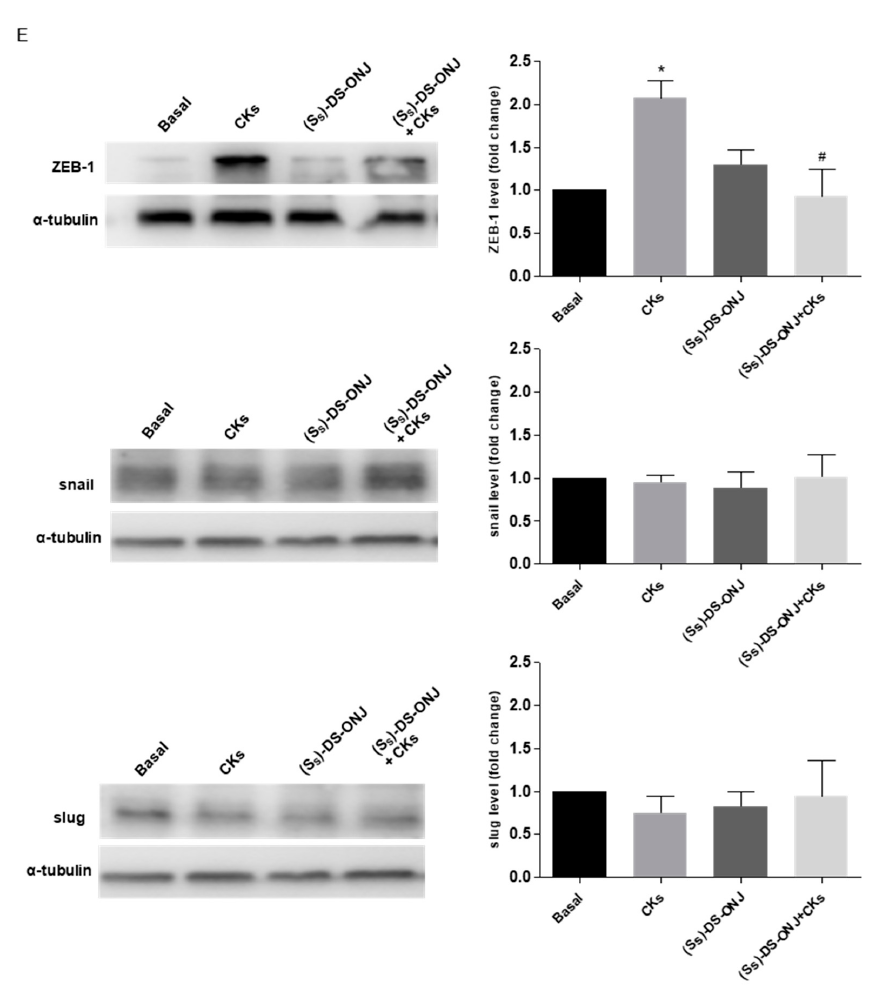
Figure 4. EMT progression is inhibited by ( S S )-DS-ONJ in CKs-stimulated MCT cells. ( A ) Protein extracts were analyzed by Western blot with antibodies against E-cadherin, α - SMA and α -tubulin as a loading control. (n = 4 independent experiments). ( B,C ) Cadherin-1 , Acta-2 , Tgfb and Il18 mRNA levels were determined by qRT-PCR. (n = 4 independent experiments performed in triplicate). ( D ) Il18 , Tgfb , Cadherin-1 and Acta-2 mRNA levels were determined by qRT-PCR after siRNA Il18 treatment and Actinb was used as housekeeping control (n = 4 independent experiments performed in triplicate). ( E ) Protein extracts were analyzed by Western blot with antibodies against ZEB-1, Snail, Slug and α -tubulin as a loading control. The fold change relative to the basal condition is shown; * p ≤ 0.05 vs. Basal condition; # p ≤ 0.05 vs. CKs stimuli (two-way ANOVA followed by Bonferroni t -